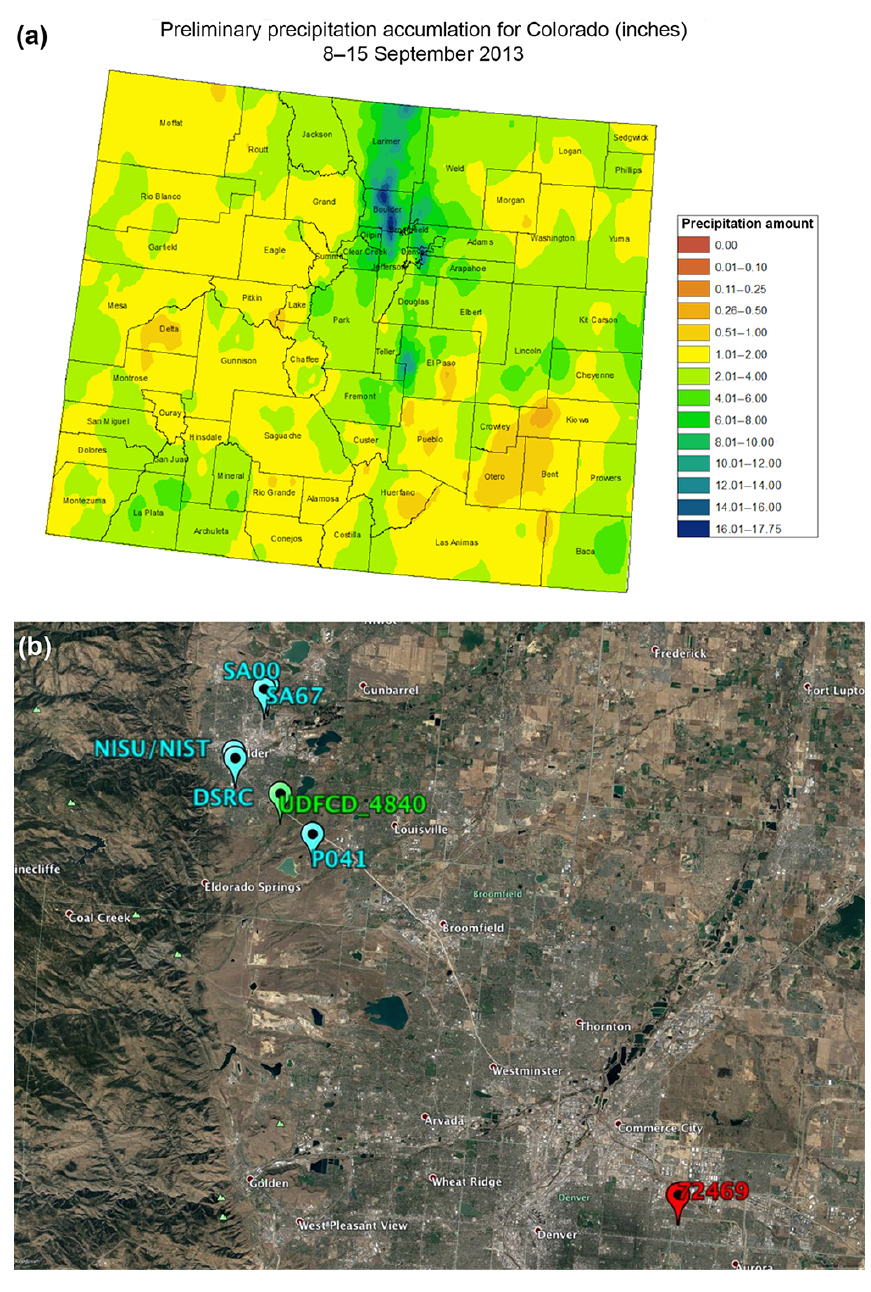
Figure 1. (a) Map of accumulated precipitation over Colorado from 8 to 15 September 2013 (image courtesy of the Colorado Climate Center); (b) the locations of the primary GPS (blue circles), rain gauge (green circle), and radiosonde (red circle) observations used in this study. NISU and NIST are the only IGS GPS stations plotted on this map. All of the other GPS stations are from the SuomiNet